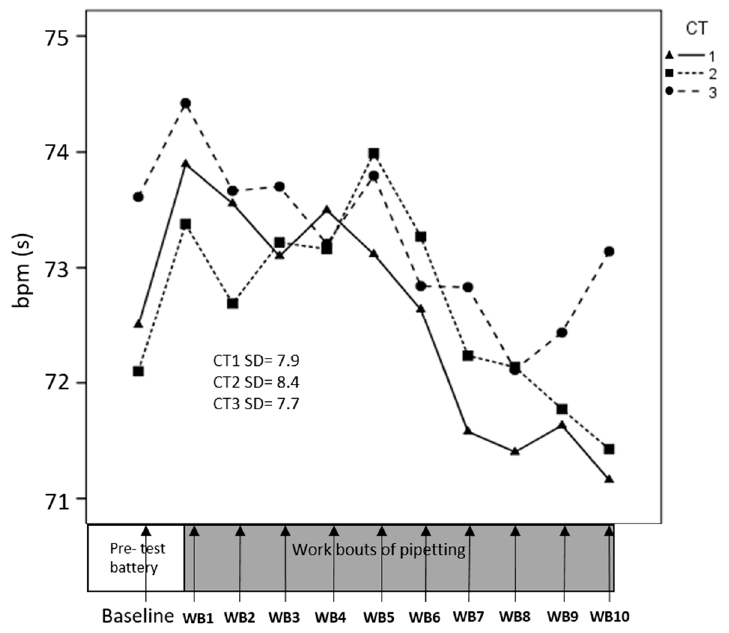
Figure 4. Heart rate (HR) across consecutive pipetting work bouts (WB). At each time point on the x-axis, corresponding to the pipetting work bouts, a mean value for HR across participants is presented. Separate lines illustrate the three cognitive task (CT) difficulties. Standard deviations (SD) refer to all participants and all time points.